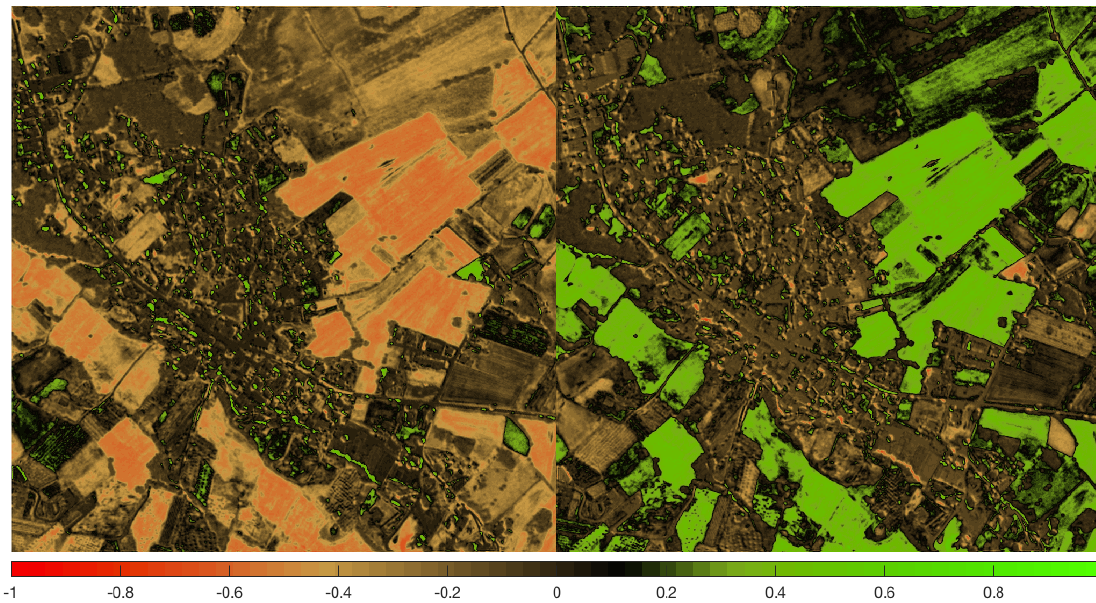
Figure 6. Normalized differential vegetation index (NDVI) of pansharpened images on 27 May 2010 and 13 July 2010. Map of differences in NDVI values: ( left ) July-to-May; ( right )